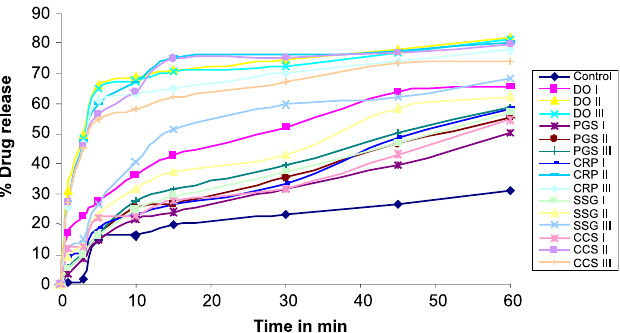
FIGURE 10 - % Drug release from tablet in Distilled water.